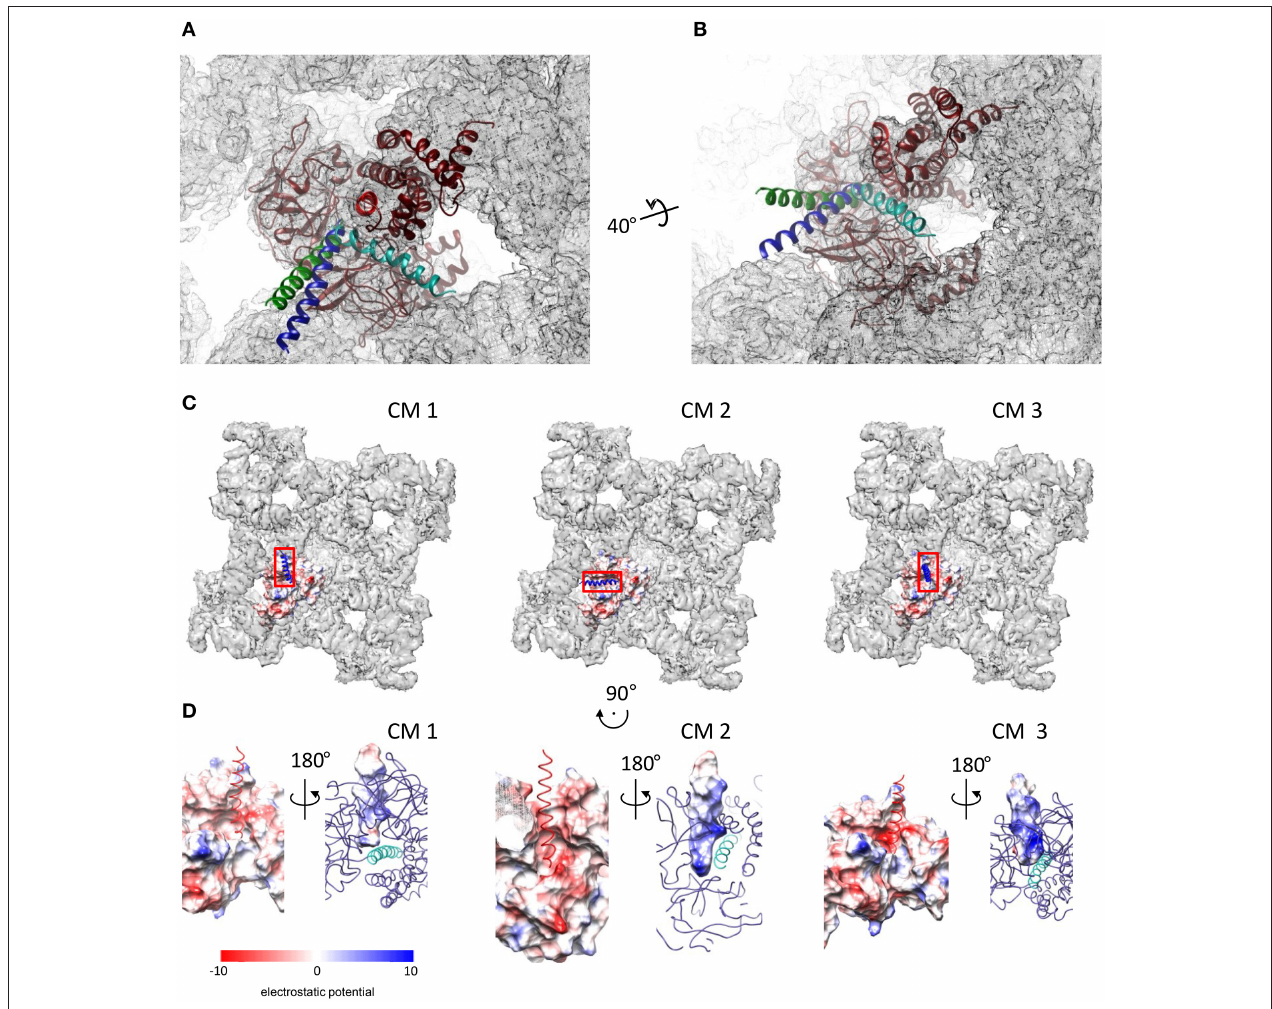
FIGURE 3 | Complexes of DP cpvtN2 with the NTR. (A,B) Two views on the plausible positions of DP cpvtN2 in the complex with NTR. (A) A view along the central helix. (B) Oblique view. The models are positioned in the cryo-EM map of oRyR1 (EMD 2807; Yan et al., 2015). The axis and angle of rotation of the second view are shown. Models CM 1–CM 3 are shown in blue, cyan and green, respectively. (C) Top views of the ryanodine receptor (EMD 2807) with the docked models of NTR in the open state, shown as electrostatic potential distribution (blue, positive; red, negative) of its surface, and with bound DP cpvtN2 shown as a ribbon. Left to right: CM 1, CM 2, and CM 3. The rectangles correspond to the areas shown in (D) . (D) Electrostatic potential distribution of the interacting interfaces of NTR and DP cpvtN2 . Rotation relative to panels in (C) is shown at the top. Left to right: CM 1, CM 2, and CM 3. In each panel, one side of the interface is shown as the electrostatic potential distribution of its surface (left—NTR; right—DP cpvtN2 ), while the complementary molecule is shown as a ribbon (left—DP cpvtN2 ; red; right—NTR, blue, with the central helix shown in a lighter shade). The complementary views (left vs. right) were created by 180 ◦ rotation around the vertical